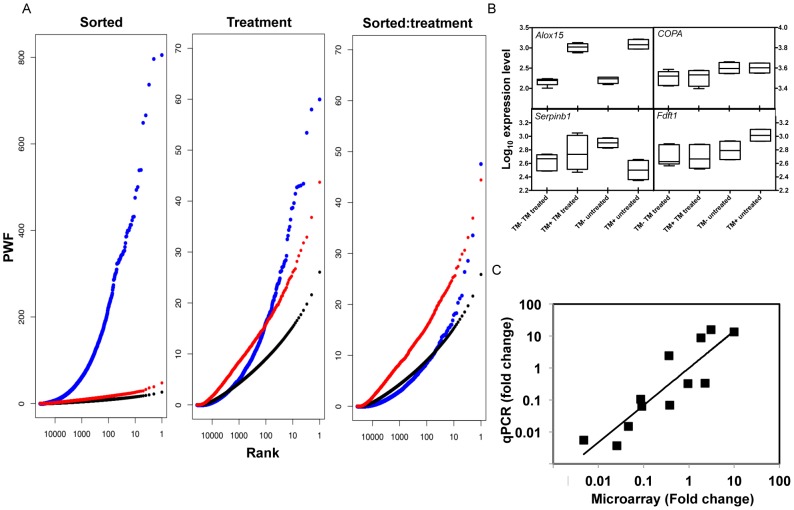
Gene expression changes in DCs following sTM treatment or sorting into TM+ or TM− DCs.(A) The mean (black) and 95th percentile (red) of PWF values for each probe rank from 500 permutations of the sample-labels as described in Materials and Methods show that the ‘sorted’ term PWF values (blue) were extraordinarily large compared to the simulations. For the ‘treatment’ term, the PWF values of fewer than 1000 probes were well above the simulated values, and for the ‘sorted:treatment’ interaction term, few probes showed a significantly higher PWF than by permuted sample-label computations. (B) PWF statistics permitted identification of genes exhibiting the strongest association with sorting into TM+ and TM− DC, for example Alox15. Similarly, genes exhibiting strong association with TM treatment included Copa. Serpinb8 exhibited a large PWF value for the sorted:treatment interaction, as seen by the contrasting effect of treatment on gene expression in TM− and TM+ DCs. Fdft1 gave large values of PWF for both treatment and sorted:treatment interaction, and shows both down-regulation with TM treatment and notably higher expression in TM+ DCs, specifically in untreated cells. (C) Correlation between gene expression changes determined by microarray to those determined by qPCR. A panel of genes (Table 1) whose expression was changed when analyzed by microarray, their fold change was also determined by qPCR. The qPCR data was normalized to GAPDH resulting in this equation for the best fit line: log y = (0.99 *log x) +1.16 with R2 = 0.79.